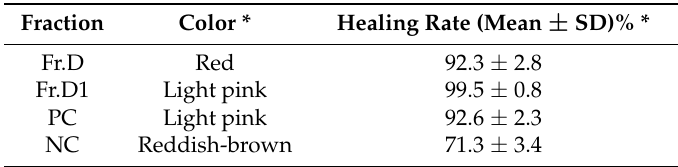
Table 2. Comparison of water fraction Fr.D and water elution fraction Fr.D1 on day 9 in wound-healing (PC: positive control group; NC: negative control group) activities. Fraction Color * Healing Rate (Mean ± SD)% * Fr.D Red 92.3 ± 2.8 Fr.D1 Light pink 99.5 ± 0.8 PC Light pink 92.6 ± 2.3 NC Reddish-brown 71.3 ± 3.4 * The color and healing rate of wounds on day 9. SD: standard deviation.